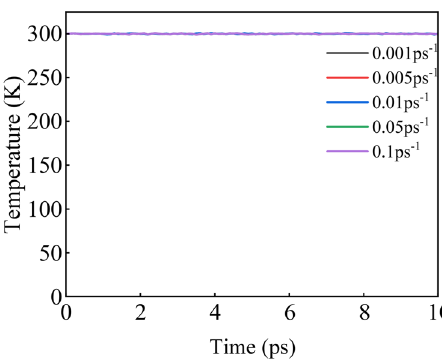
Figure 16: Temperature change during relaxation.